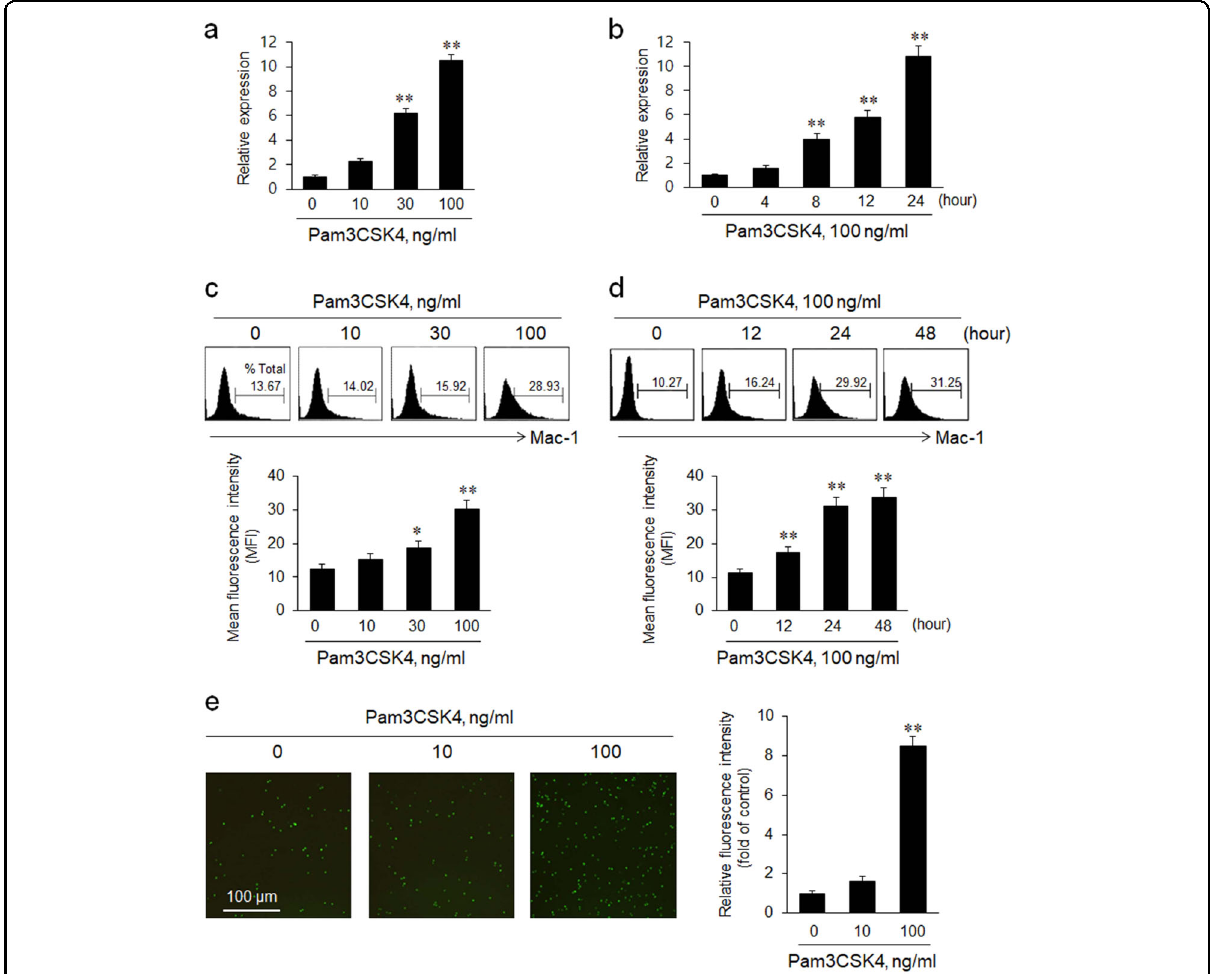
Fig. 1 The functional role of TLR2-induced Mac-1 expression in monocyte adhesion to endothelial cells. a , b THP-1 cells were treated with the indicated concentrations of Pam3CSK4 for 24 h or treated with 100 ng/mL Pam3CSK4 for the indicated times. The total RNA isolated from cells was analyzed for the expression of Mac-1 mRNA using real-time PCR. Quantitative data are presented as the means ± SEM of six independent experiments. **P < 0.01 compared with the control. c , d Surface expression of Mac-1 protein on THP-1 cells was determined using a phycoerythrin (PE)-conjugated anti-Mac-1 antibody, and presented as mean fl uorescent intensities (MFI). Quantitative data are presented as the means ± SEM of seven independent experiments. *P < 0.05 and **P < 0.01 compared with the corresponding control. e THP-1 cells were stimulated with the indicated concentrations of Pam3CSK4 for 24 h, labeled with calcein-AM for 30 min, and then co-cultured with HUVECs for 2 h. THP-1 cells that adhered to HUVECs were visualized under a fl uorescence microscope. Scale bar = 100 μ m. Quantitative data are presented as the means ± SEM of four independent experiments. **P < 0.01 compared with the